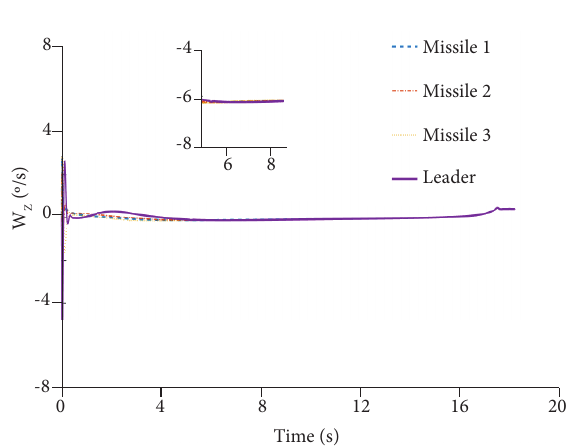
Figure 12. Pitch angular velocities of the interceptors obtained using the regular cooperative control